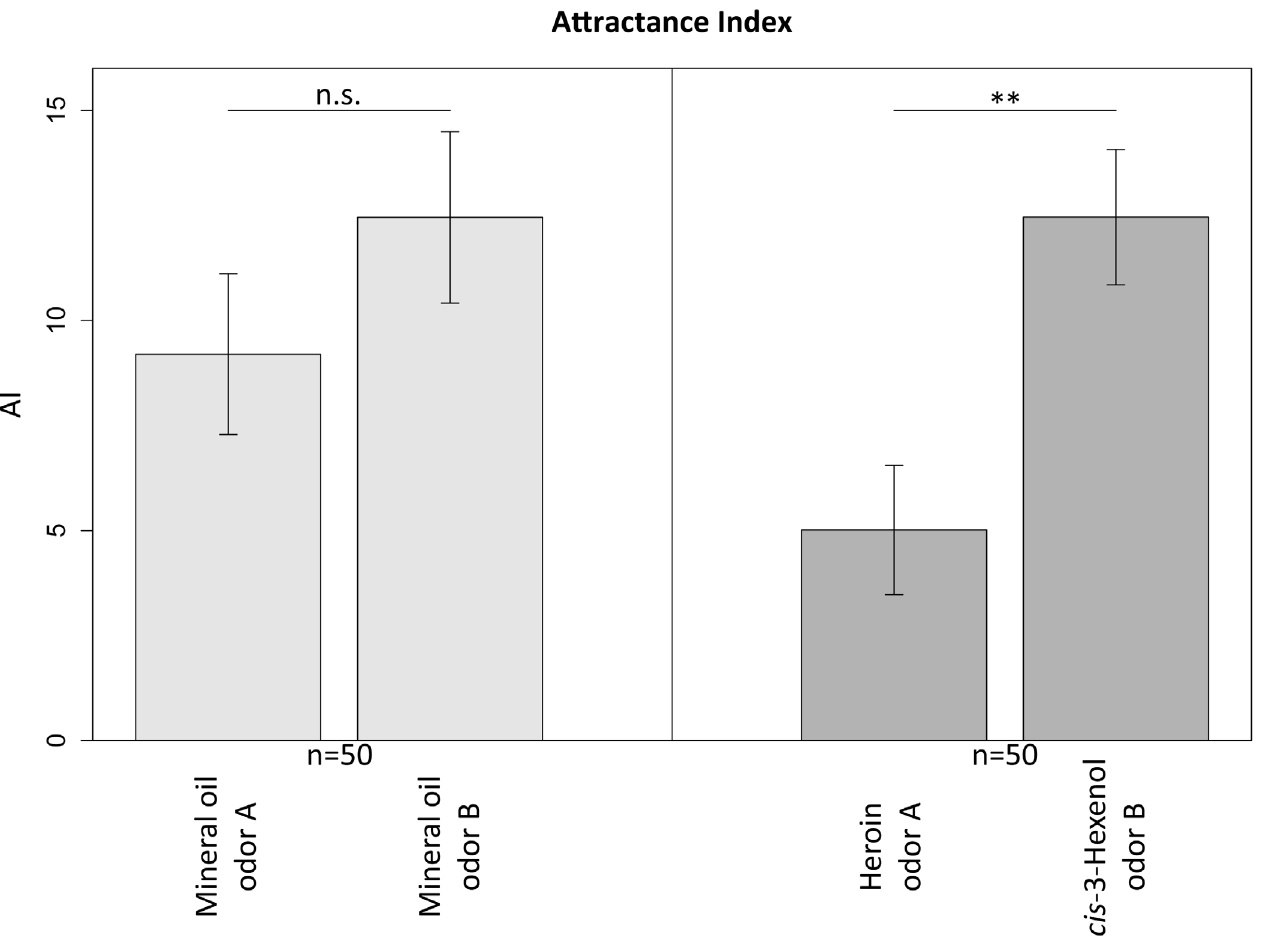
Fig 4. Mean attractance index values of the blank/blank and the heroin/ cis -3-hexenol experiment in the test phase without an unconditioned stimulus. Odor A was the conditioned odor paired with the unconditioned stimulus in the conditioning phase, and odor B was presented always without the unconditioned stimulus. Error bars indicate standard errors (n = 50) and ** indicates a significant difference (p (cid:1) 0.001).